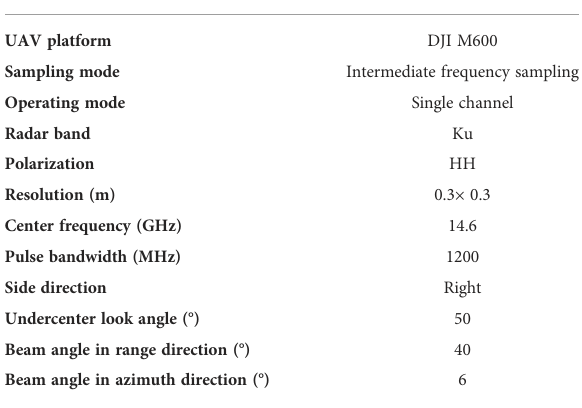
TABLE 1 The parameters of UAV-based MiniSAR